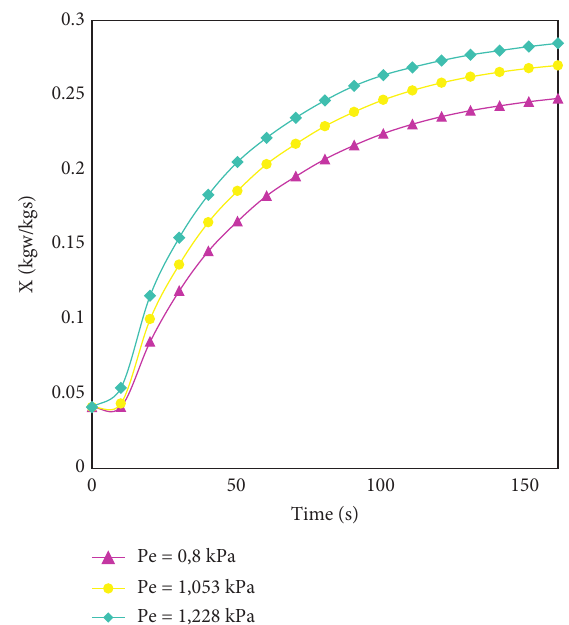
Figure 7: Variation of average SAPO-34 uptake with time for different P